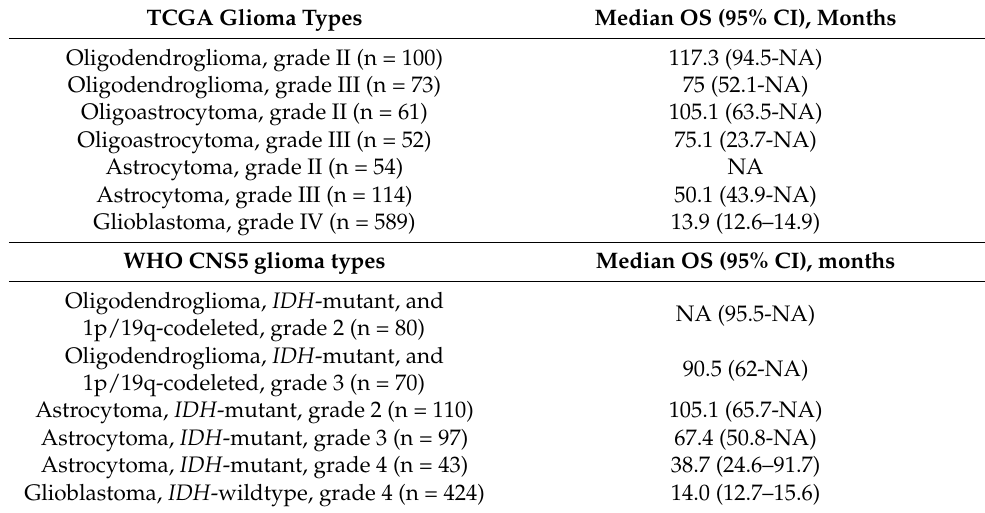
Table 1. Median overall survival for TCGA-LGG and TCGA-GBM diffuse gliomas before (upper panel) and after (bottom panel) the classification according to the WHO CNS5